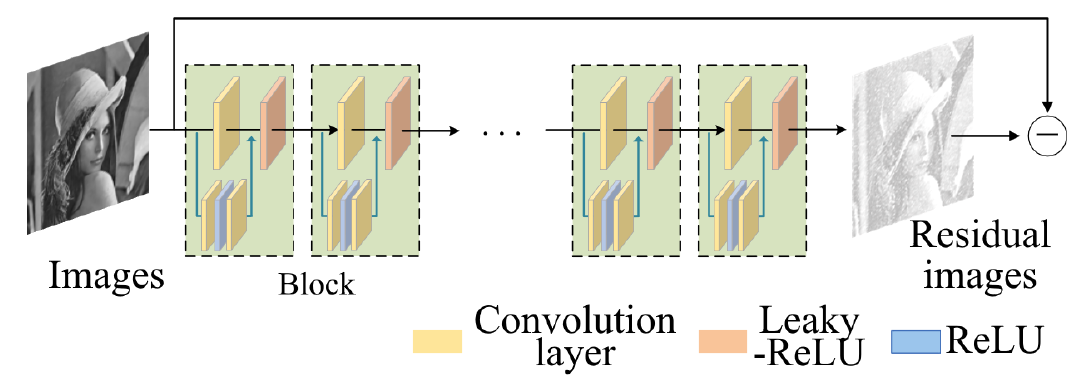
Figure 1. The flow chart of watermark attack algorithm.